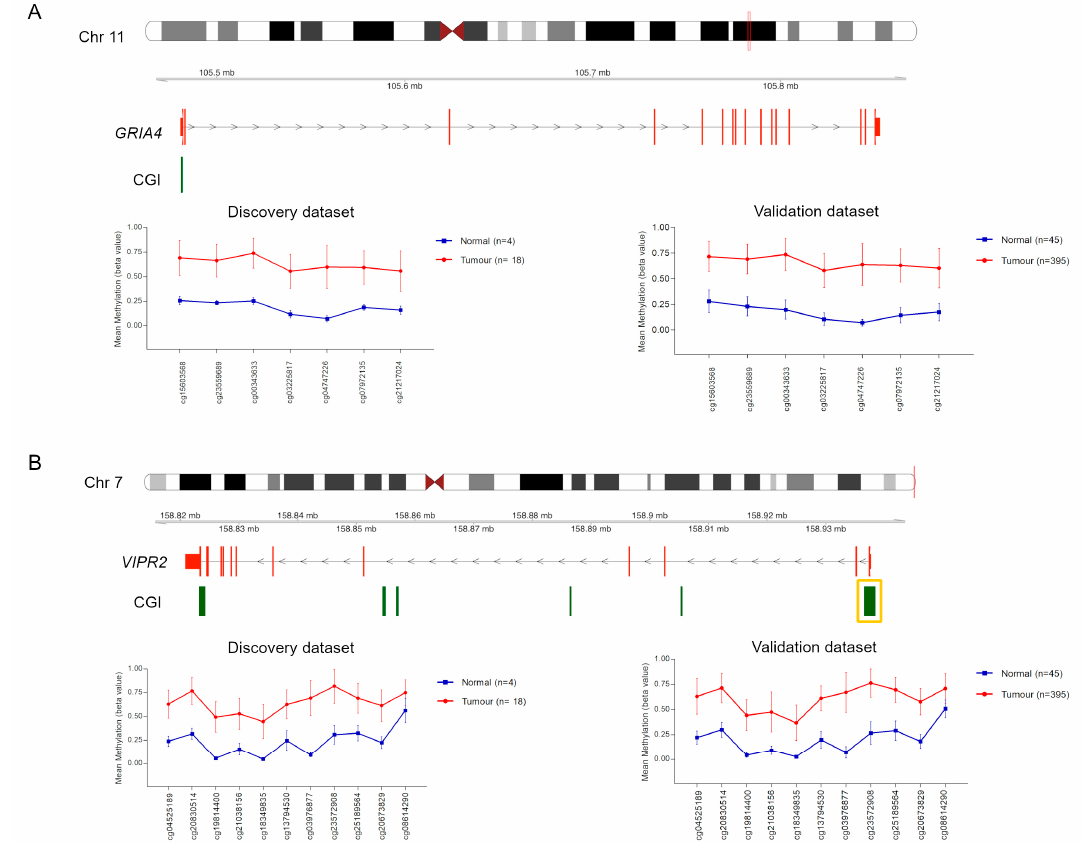
Figure 1. Methylation values obtained from our colorectal (CRC) discovery set and The Cancer Genome Atlas (TCGA) validation set. Genomic organization of GRIA4 ( A ) and VIPR2 ( B ), including the localization of exons and CGIs. Mean β values, resulting from the average of the samples (normal and tumour) of each probe mapping on the altered CGIs associated with GRIA4 ( A ) and VIPR2 ( B ). When more than one CGI is shown, the altered one is enclosed in a yellow